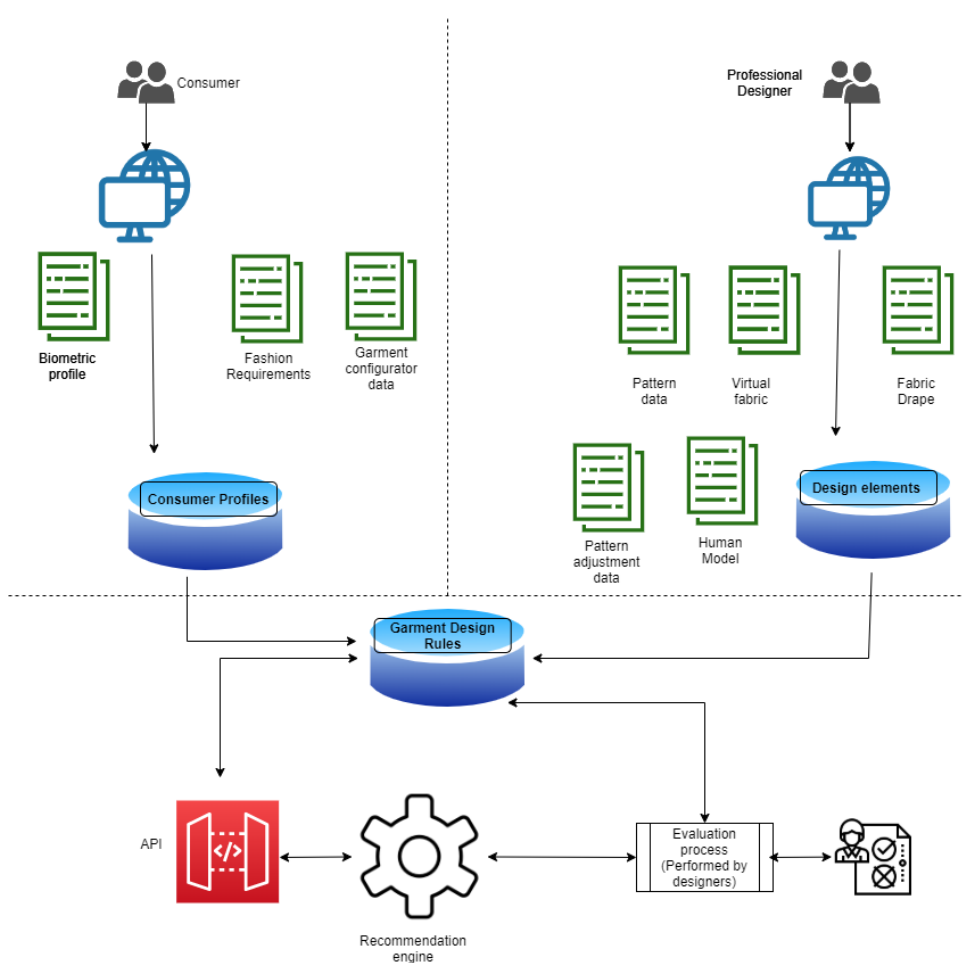
Figure 2. The structure of the proposed garment knowledge